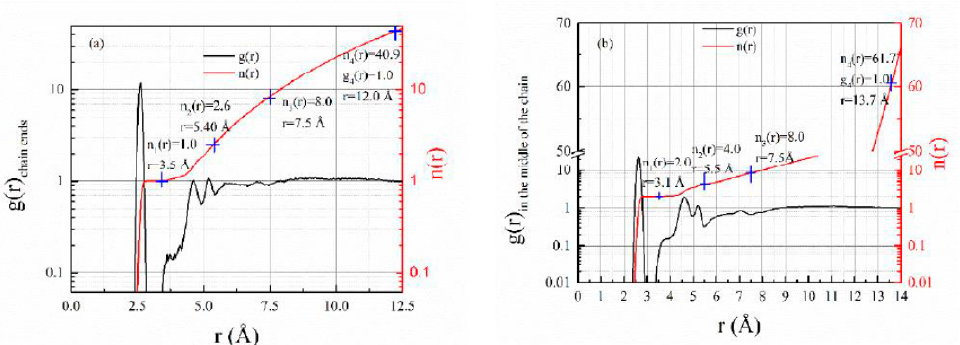
Figure 2. The radial and number distribution functions for chain ends ( a ) and monomers in the middle of chains ( b ) at 393 K. Here, we used the main chain carbon which connected to phenyl ring to represent a monomer.